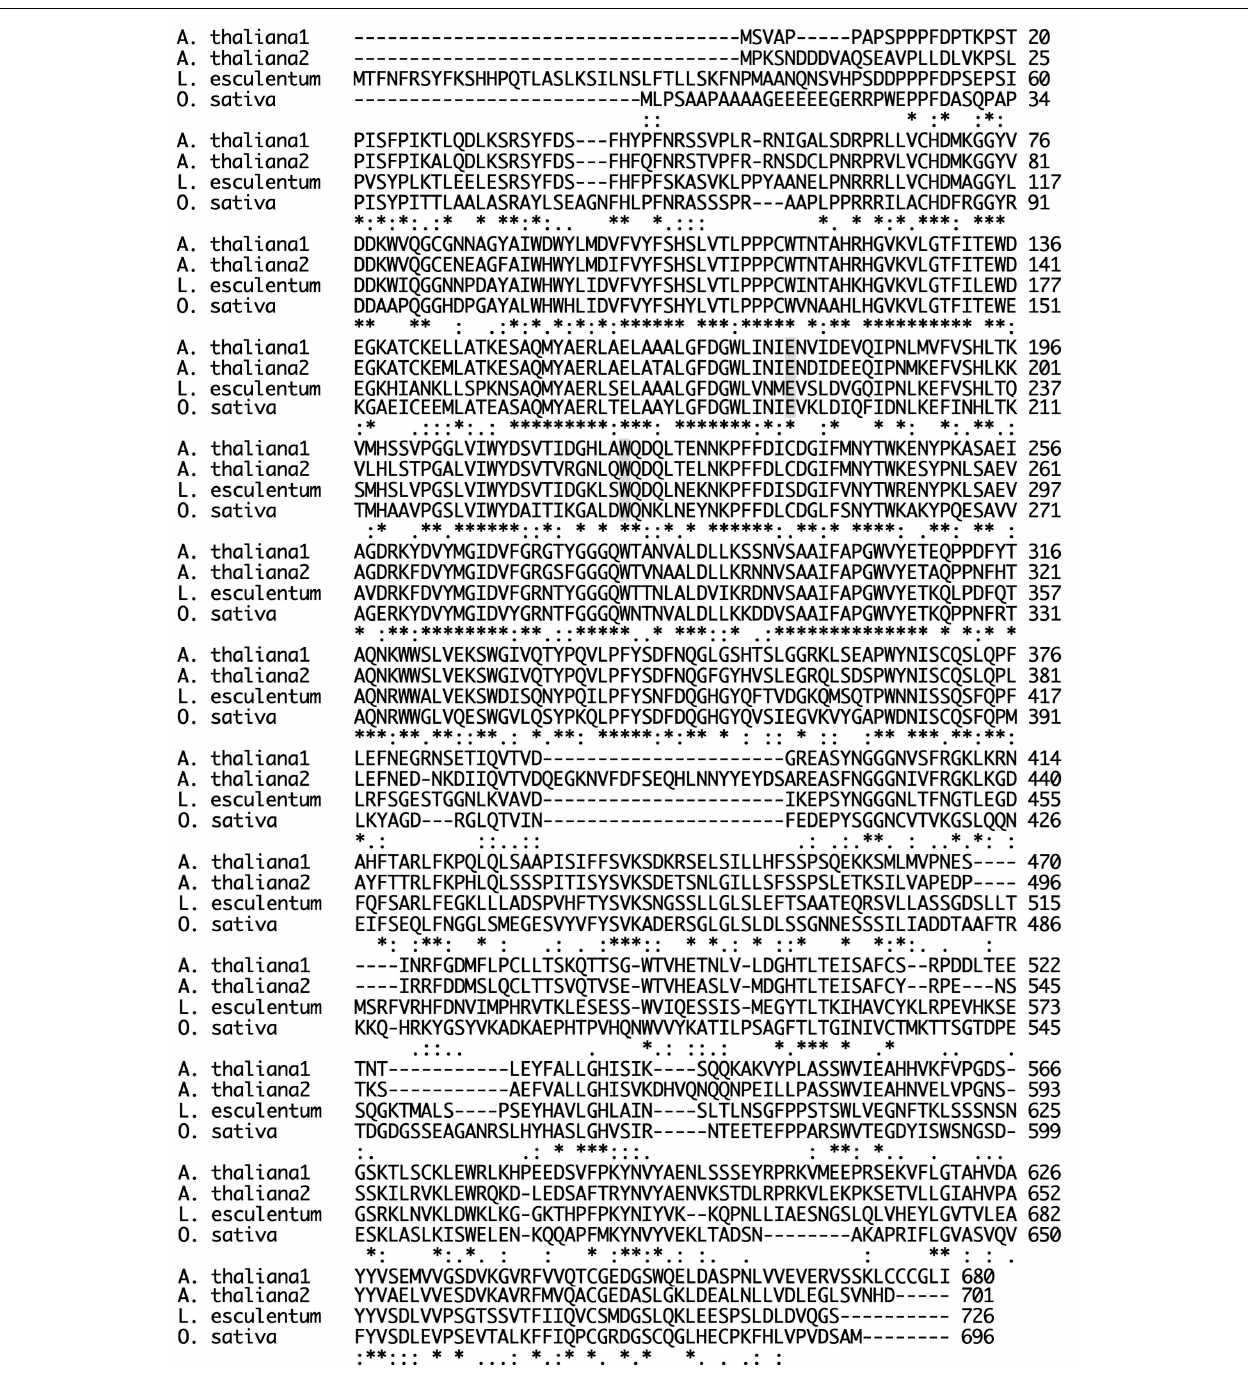
FNGs function as signaling molecules involved in plant growth or development (Priem and Gross, 1992; Yunovitz and Gross, 1994); however, the putative functions remain to be